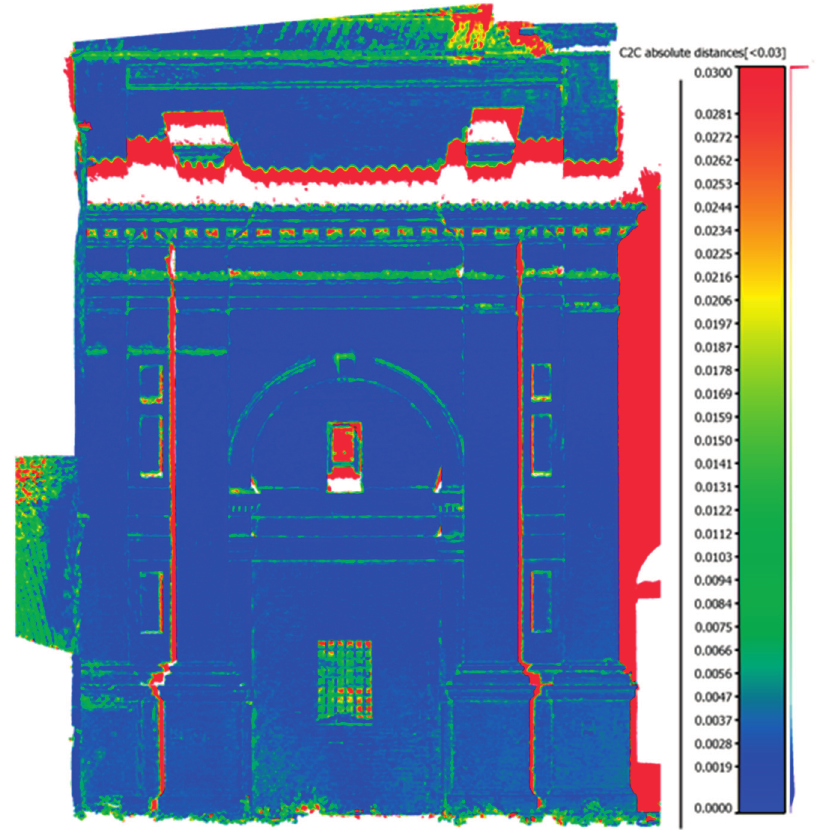
Figure 3. Comparison of photogrammetric point clouds with laser scanner one. The maximum difference, shown in red color, is 3 cm and it is present only on the borders or in missing